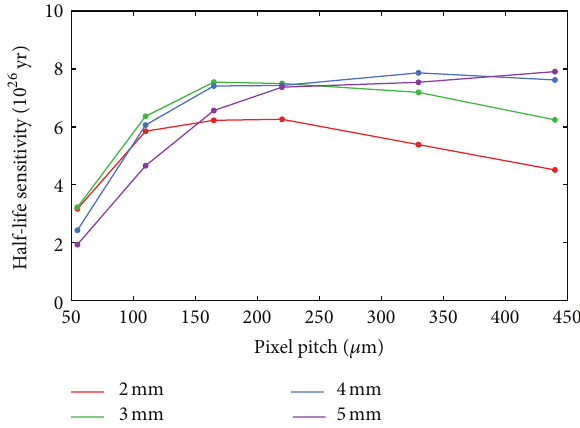
Figure 7: Simulated relative energy resolution Δ𝐸 various combinations of pixel pitch and sensor thickness. Figure 8: Simulated half-life sensitivity of a 420 kg CdTe pixel